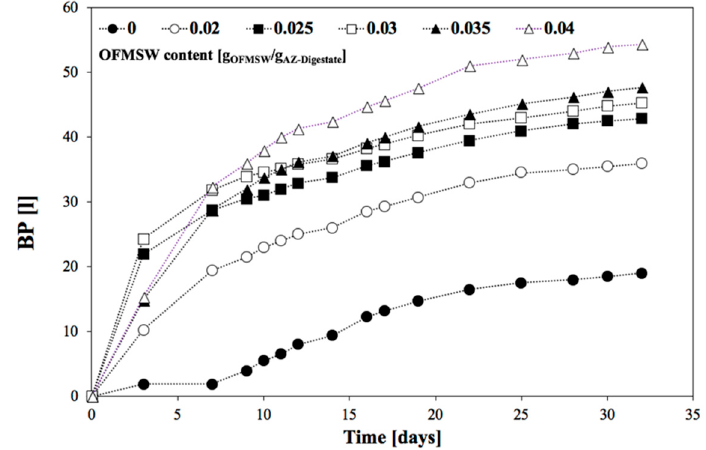
Figure 4. Biogas productivity as a function of reaction digestion time during batch wet-AD of agro-zootechnical (AZ) digestate containing a different tenor of OFMSW.